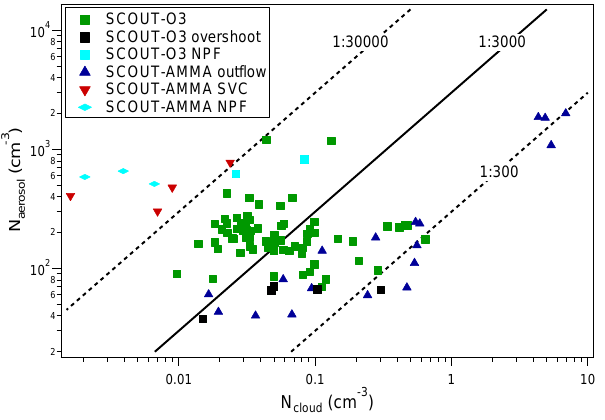
Fig. 18. Interstitial aerosol and cloud particle in situ measurements of tropical cloud encounters in West-Africa (2006) and Northern Australia (2005). The ordinate shows the aerosol particle num- ber concentration (measured by COPAS as proxy for the intersti- tial aerosol) covering size diameters between 15nm (or 10nm in a few cases) and roughly 1µm. The abscissa gives the simultane- ously detected cloud particle number densities for sizes above 2µm as measured by the CIP and FSSP-100 probes. The events are from the Australian Hector MCS (squares), the West African MCS out- flows (blue triangles), and the West African SVCs (red triangles). Furthermore, NPF events are indicated in light blue. The lines indi- cate activation ratios in terms of the numbers of cloud particles and the available aerosol